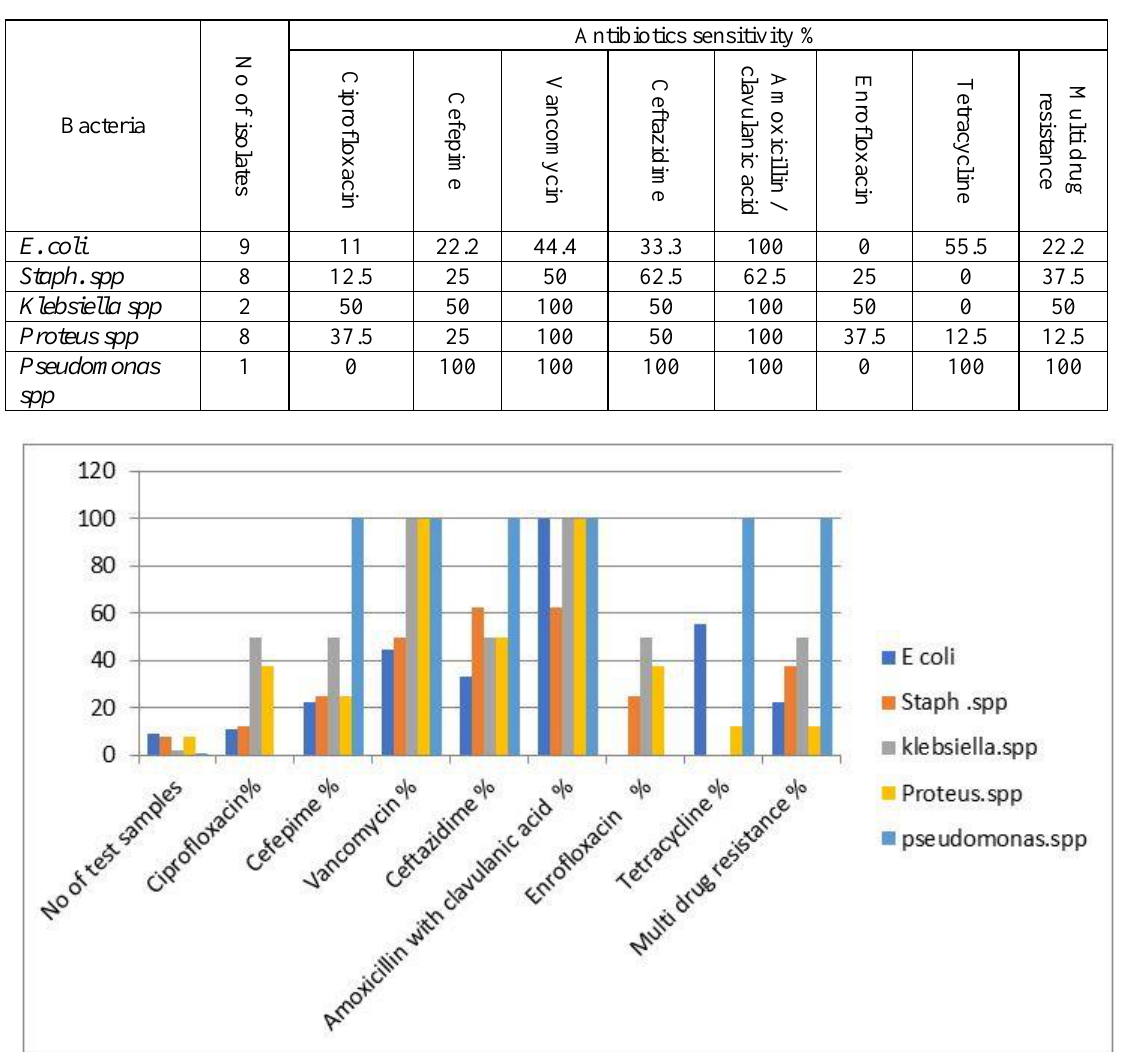
Table 4: Showing resistance prevalence of antibiotics toward each bacterial UTI and MDR prevalence